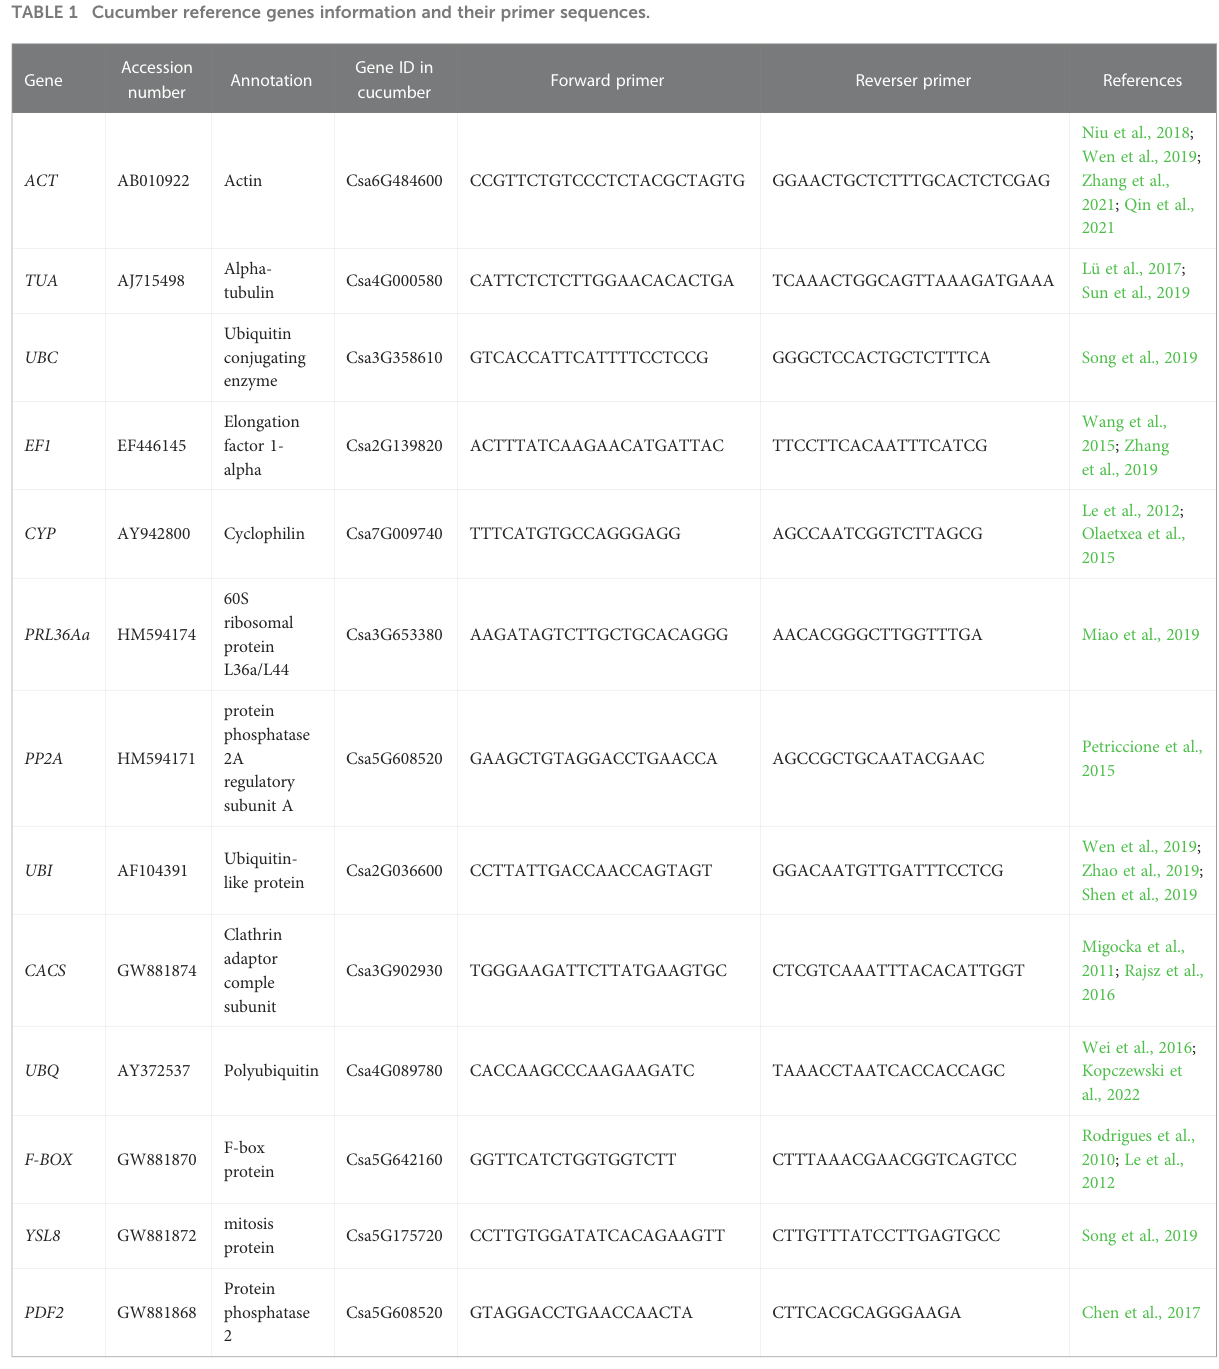
TABLE 1 Cucumber reference genes information and their primer